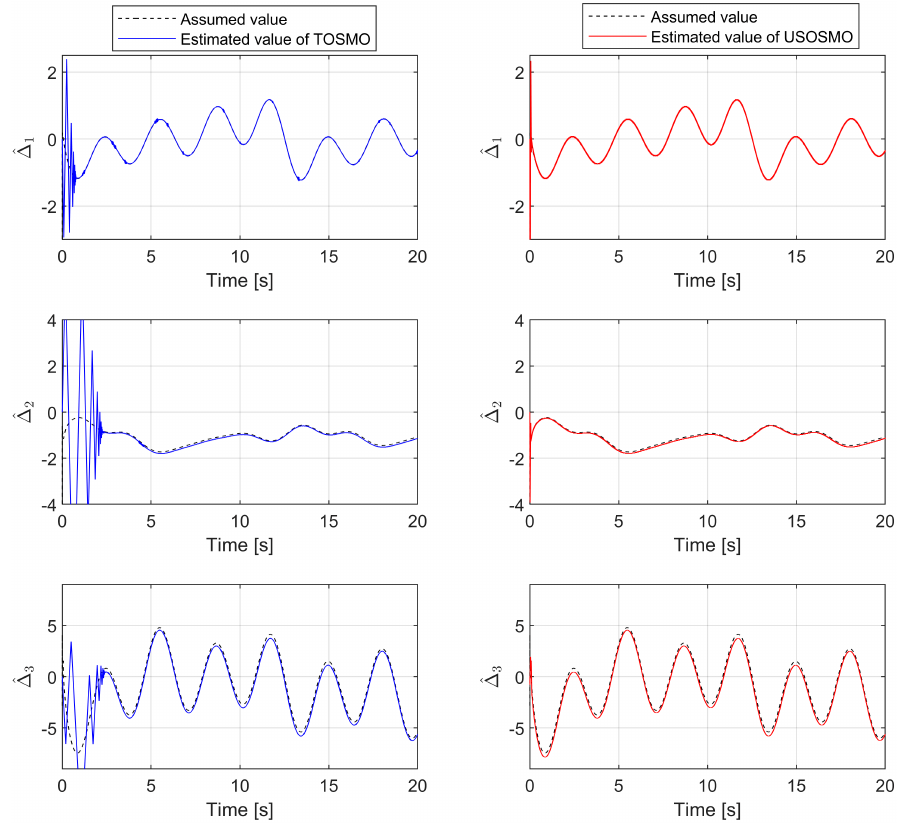
Figure 4. The description of performance estimation from the FnTDO and the proposed